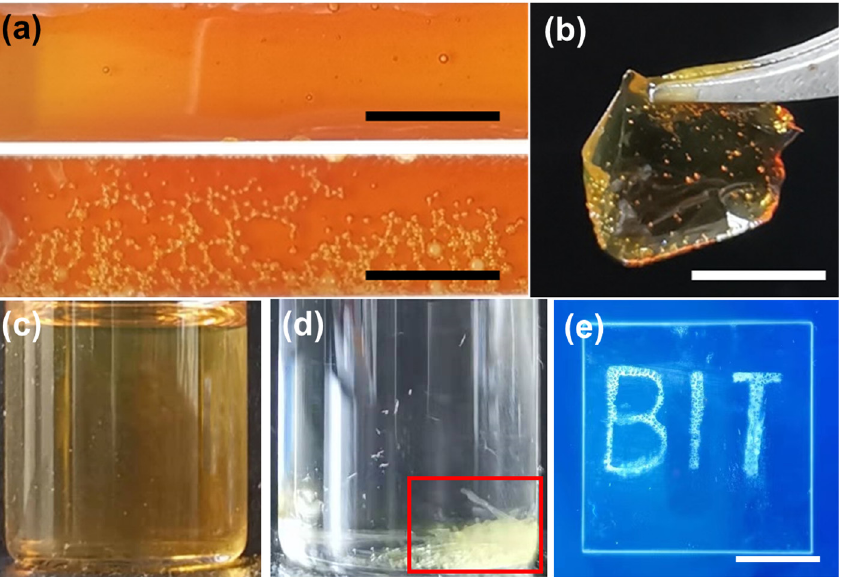
Figure 1. Photographic images of ( a ) GAP samples before (upper) and after (lower) UV ‐ irradiation (254 nm, 20 min); ( b ) a free ‐ standing crosslinked GAP film; ( c ) pristine GAP and ( d ) crosslinked GAP film in THF; ( e ) A pattern of “BIT” letters produced by irradiating the GAP film with a photo ‐ mask. The fragmented GAP film pieces highlighted in red square in ( d ). Scale bars are 1 cm.